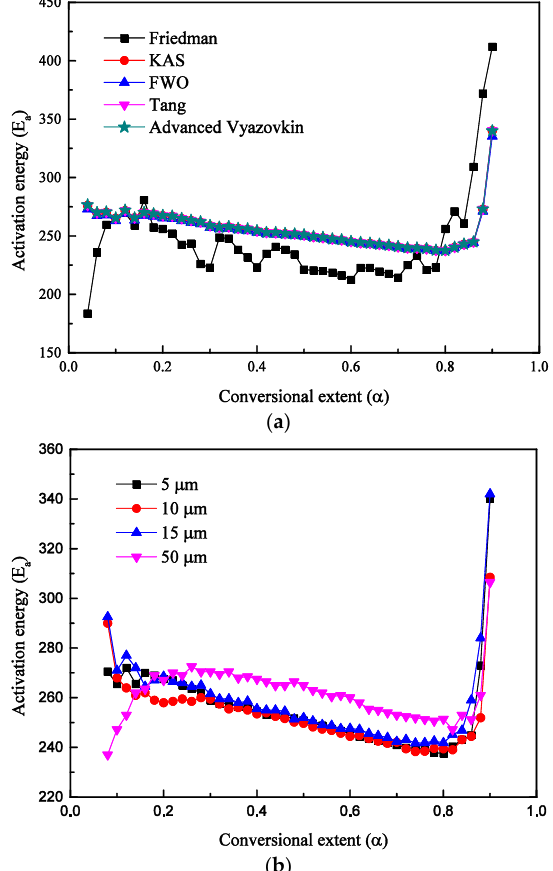
Figure 3. ( a ) Dependencies of the activation energy on extent of polystyrene conversion determined by five iso-conversional methods including KAS, FWO, Tang, Friedman, and advanced Vyazovkin methods. ( b ) Dependencies of the activation energy on conversional extent of four di ff erent size polystyrene determined by Vyazovkin